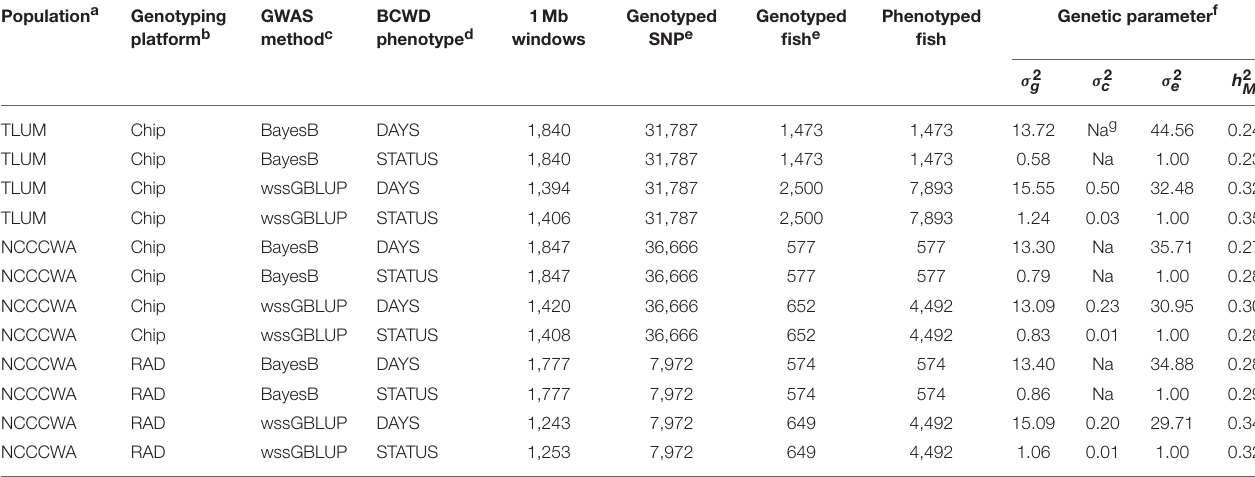
TABLE 1 | Experimental variables of GWAS conducted in two rainbow trout populations using two SNP genotyping methods. Population a